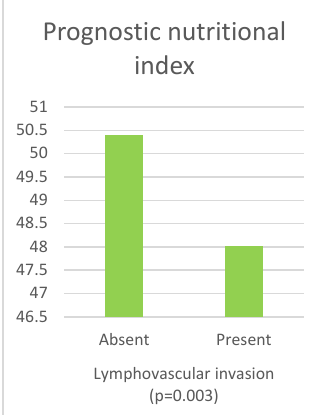
Figure 6. Significant difference in PNI between patients with and without LVI.